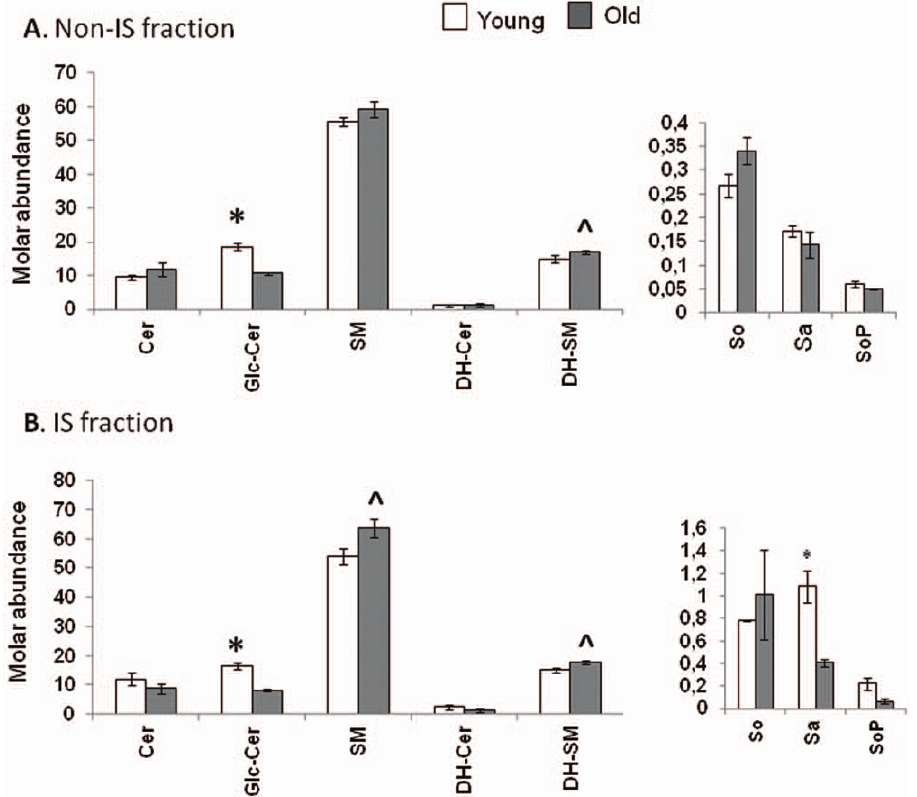
Figure 3. The mole fraction of Glc-Cer relative to total sphingolipid is significantly reduced in both the (A) non-IS and (B) IS fractions derived from aged CD4 + T cells. Bar graphs illustrating the relative abundance of sphingolipid classes in CD4 + T cell fractions, expressed as molar percents for each class in relation to the total sphingolipids and dihydrosphingolipids detected in each age group and fraction. The sphingolipid and dihydrosphingolipid picomol values reported in figures 2 were added to generate the total sphingolipid amounts for each age group and fraction. These values were then used as the basis to calculate the relative molar sphingolipid proportions, according to the formula:Molar %=(Sphingolipid Class in pmol)/((Total Sphingolipids in pmol) + (Total Dihydrosphingolipids in pmol)) 6 100. (* p , 0.05, ‘ p , 0.1 between age groups).